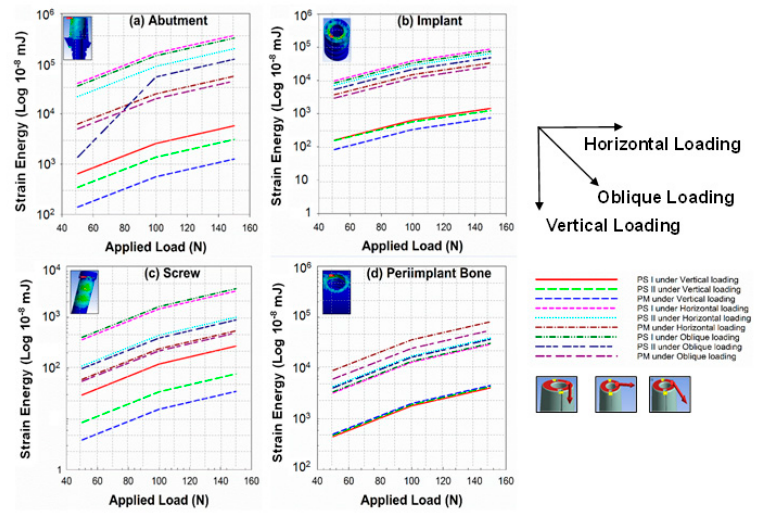
Figure 8. Graphs representing strain energy analysis of ( a ) abutment, ( b ) implant, ( c ) screw, and ( d ) peri-implant bone for PS I, PS II, and PM configuration under different loading conditions.